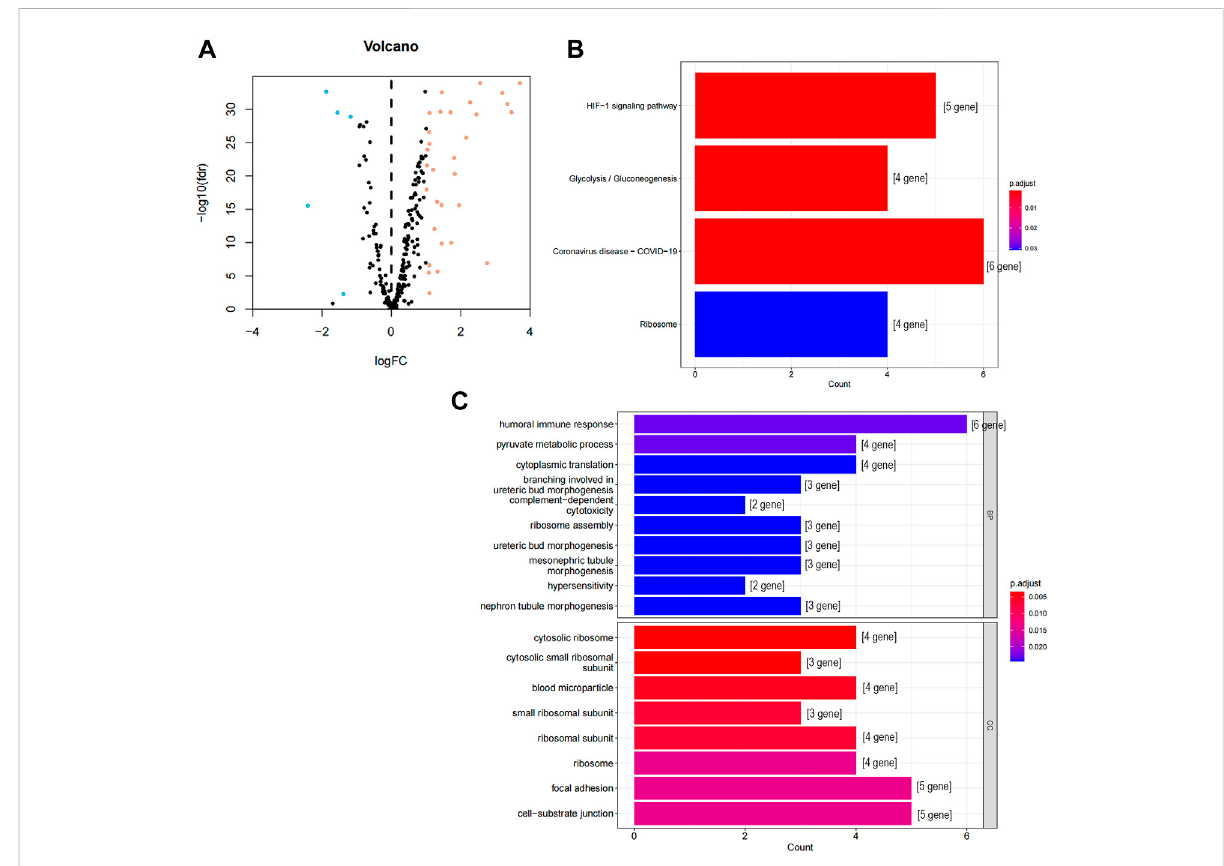
FIGURE 2 GO and KEGG analysis of CCCH-type zinc fi nger-related DEGs in cancer and adjacent tissues. (A) 262 CCCH-type zinc fi nger-related genes in ccRCC. Yellow dots indicate up-regulated genes and bluedots indicate down-regulated genes. (B) KEGG analysisof CCCH-typezinc fi